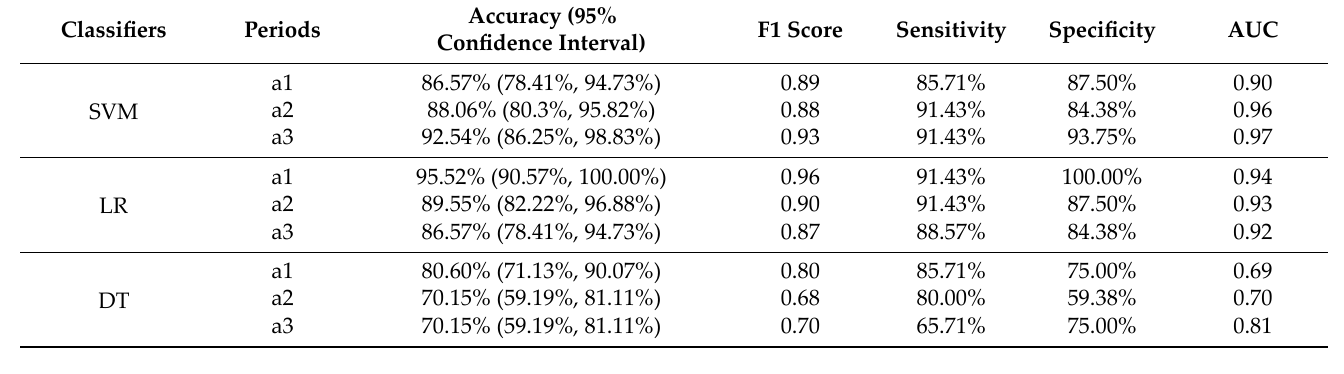
Table 7. Precision, sensitivity, and specificity values achieved for ERPs and EROs by the SVM, LR, and DT algorithms for the Elman neural network.